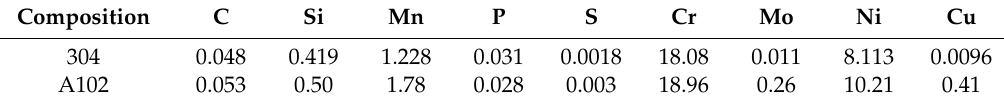
Figure 1. Dimensions of the repair welding sample. Table 1. Chemical compositions of parent metal and welding wire (wt. Table 2. Main parameters of X ‐ ray diffraction (XRD) measurement.